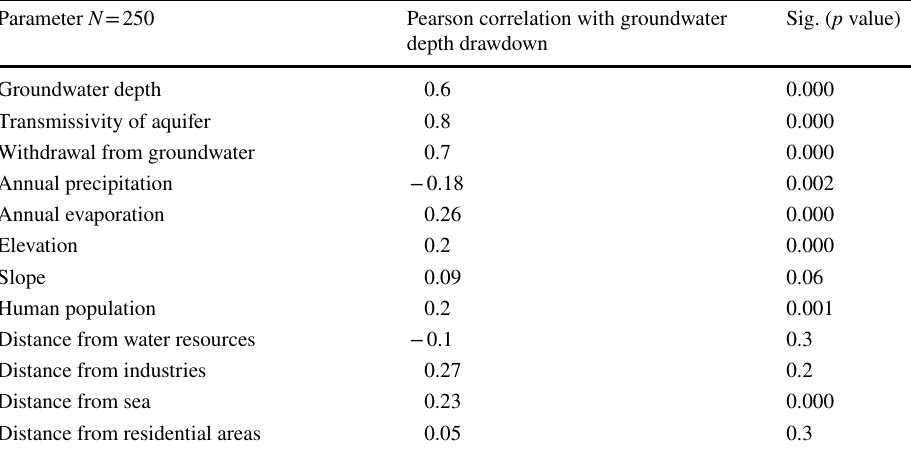
Parameter N = 250